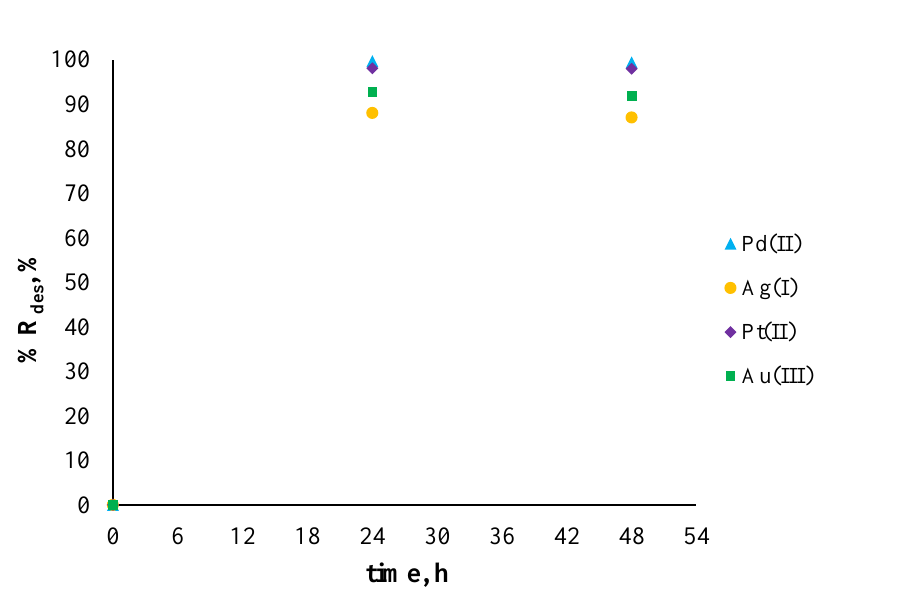
Figure 8. The sum of desorbed metal ions after 24 and 48 h from the surface of membranes previously used to absorb metal ions from single-component solutions. The given values of %R des carry ±0.01.